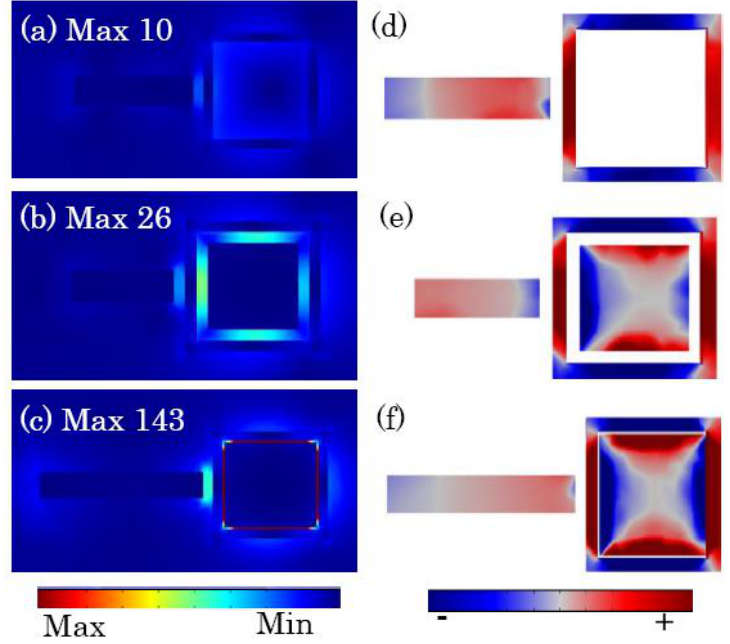
Figure 4. ( a – c ) The electric field amplitude in the middle section; ( d – e ) the induced surface charges on the top surfaces of the RCSRD with the gap g between the ring and disk of 100 (RSR), 20 and 5 nm,